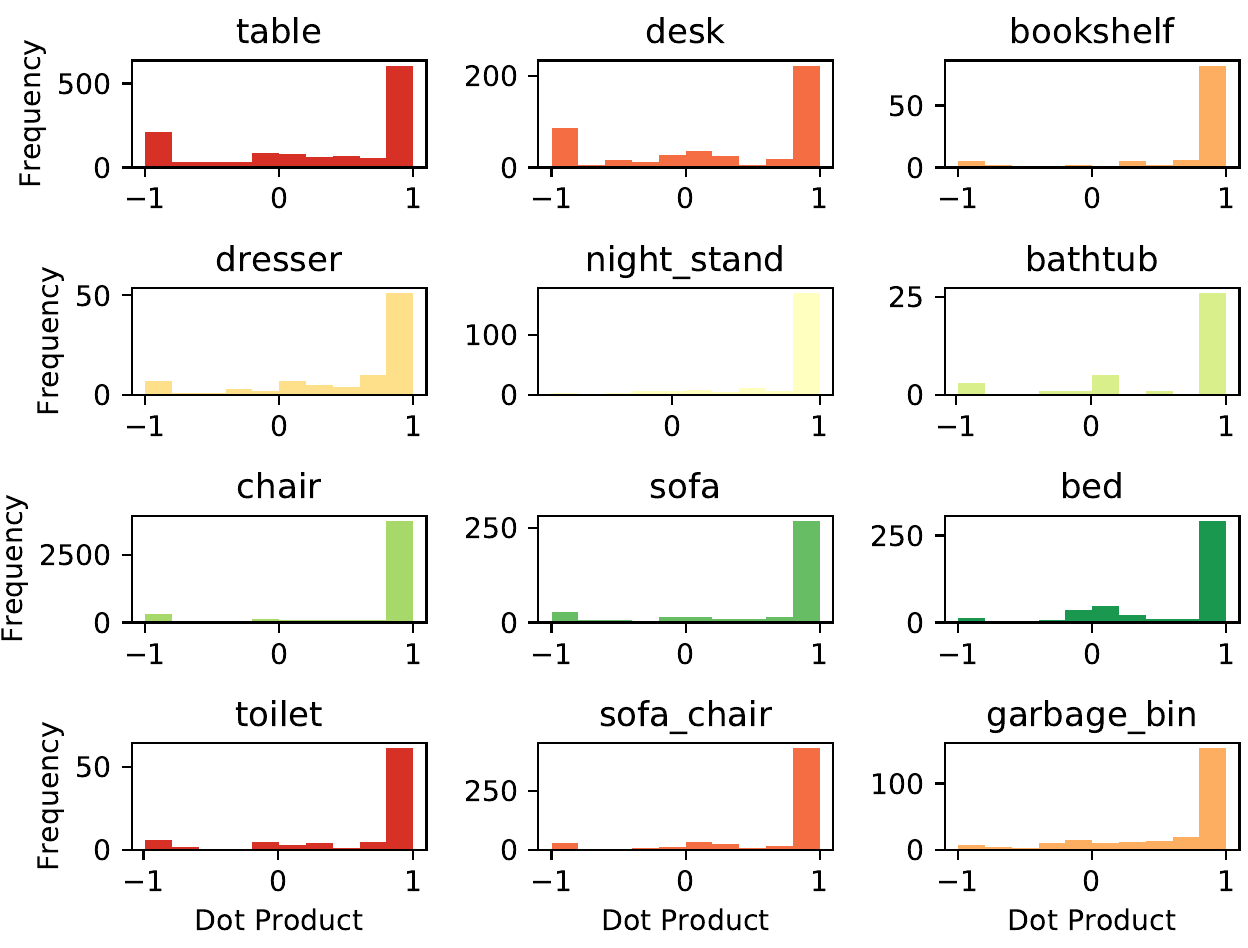
Figure 10. Histogram of the dot product between predicted orientation and ground truth orientation. Histograms are not